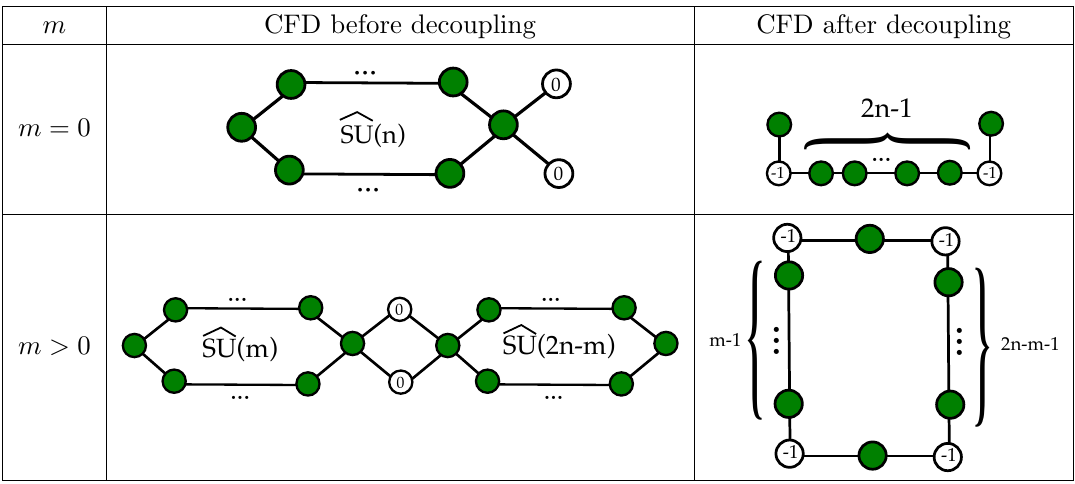
Table 10. CFDs for su ( n ) on a ( (cid:0) 2)-curve in the description on the tensor branch in terms of su ( n ) [SU( m )] (cid:0) 2 (cid:0) [SU(2 n (cid:0) m